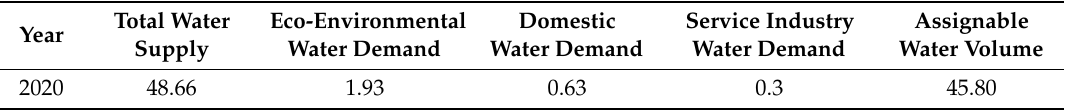
Table 4. Assignable water volume for Bayannur City in